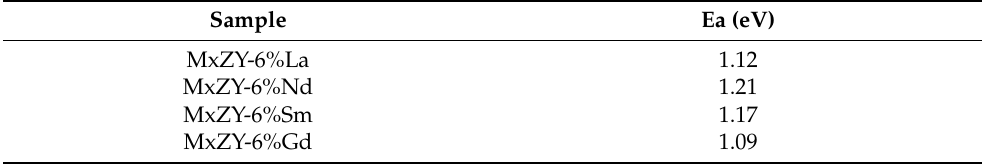
Table 6. Activation energy of conduction for ZrO 2 co-doped with 8 wt.% Y 2 O 3 -6% Ln 2 O 3 (Ln = La, Nd, Sm and